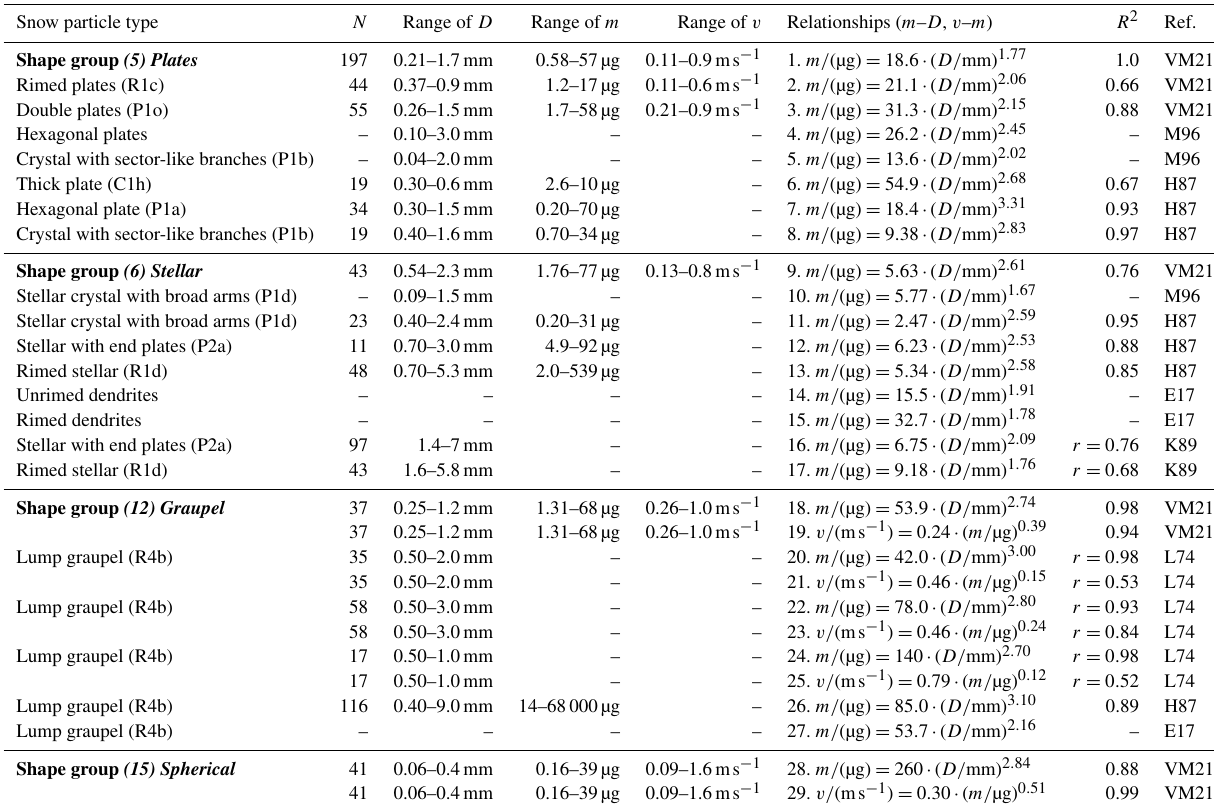
Table 2. The m vs. D and v vs. m relationships of previous studies given by Locatelli and Hobbs (1974) L74, Heymsfield and Kajikawa (1987) H87, Kajikawa (1989) K89, Mitchell (1996) M96, and Erfani and Mitchell (2017) E17 are shown for some shapes that were selected for the comparison and correspond to (5) Plates , (6) Stellar , (12) Graupel , and (15) Spherical . The power laws for M96 have been determined by using Eq. (15) in Mitchell, 1996. The relationships in this study (see Table 1) have been found by fitting Eqs. (8)–(10) to our data as described in Sect. 3.2. Those selected for comparison are also shown here as VM21. The snow particle type, the total number of particles N , ranges of particle sizes D , mass m , fall speeds v , the m vs. D and v vs. m relationships, the correlation coefficient ( R 2 ), and the reference of the studies are displayed. In these references, the particle sizes are defined somewhat differently. In VM21, as well as H87 and M96, D is defined as D max . The symbols of Magono and Lee (1966) are sometimes added for shape clarification. These m vs. D and v vs. m relationships are shown in Fig. 3. The power laws from the literature have been converted in order to have the same units so that mass m is in micrograms, particle size D in millimetres, and fall speed v in ms − 1